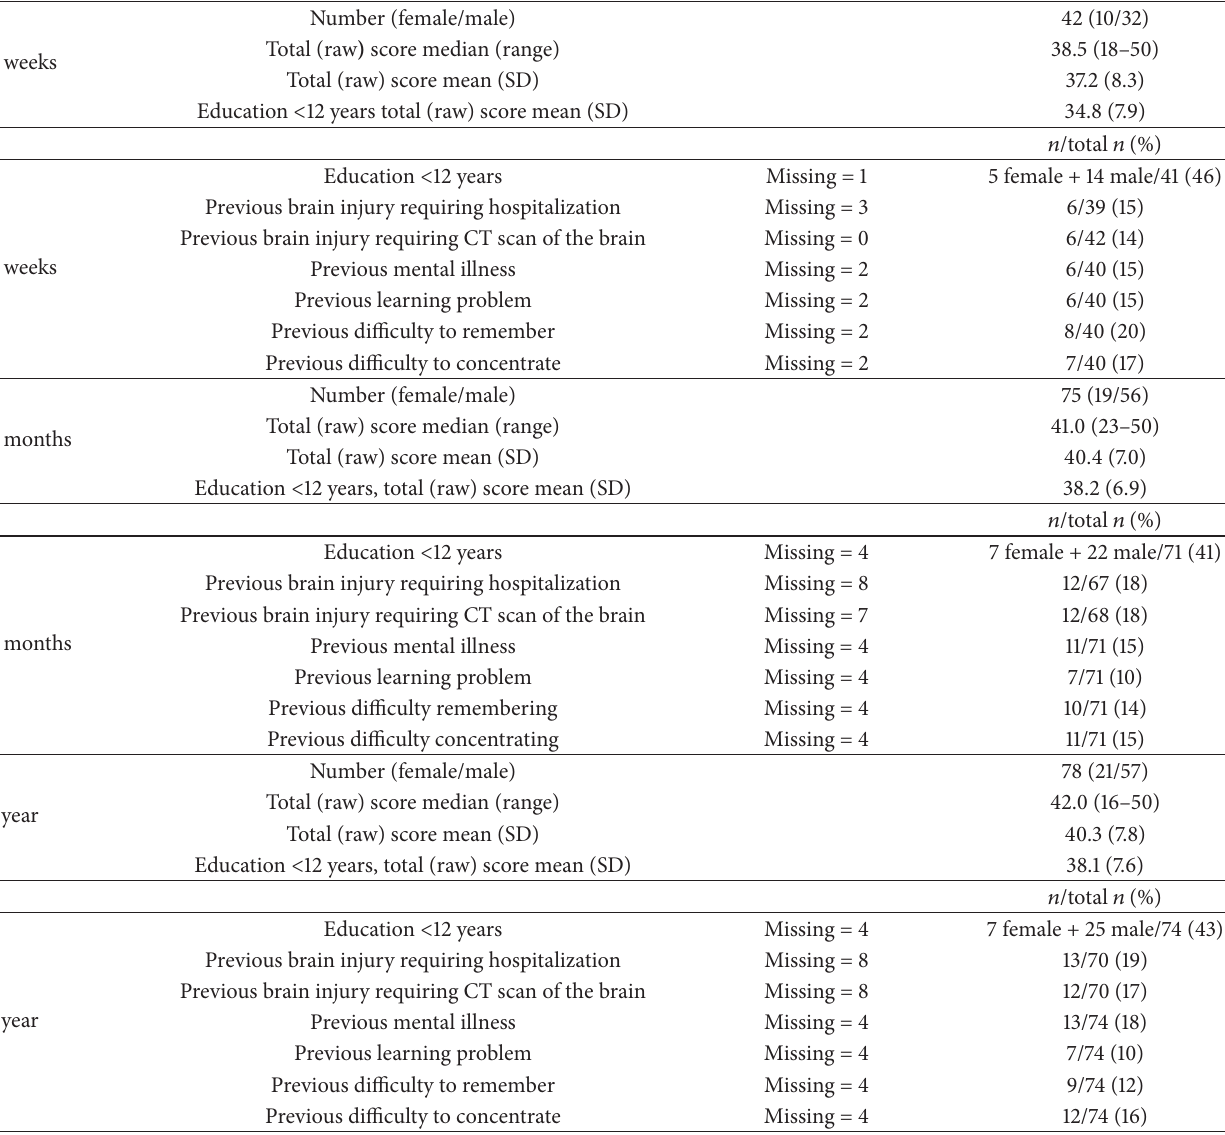
Table 3: BNIS total (raw) score at 3 weeks, 3 months, and 1 year and description of educational level and previous medical disorders (including any learning, memory, or concentration